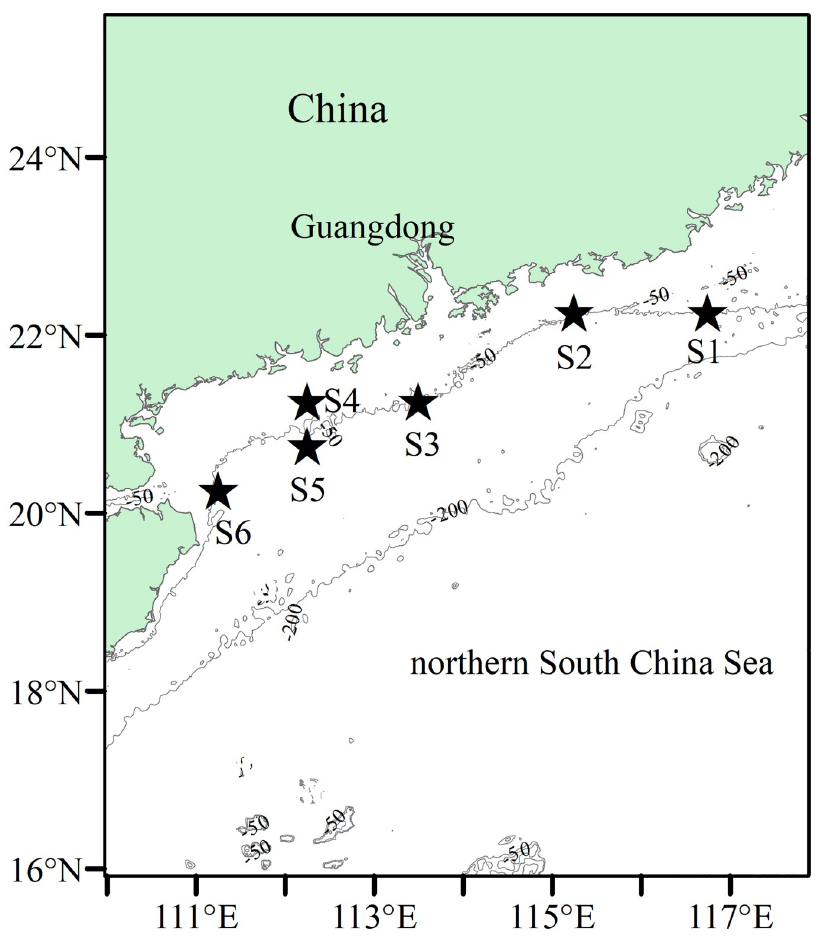
Fig 1. Study area and sampling stations in the northern South China Sea. Stars indicate the sampling stations. Grey lines indicate the selected isobaths of -50m and -200m.